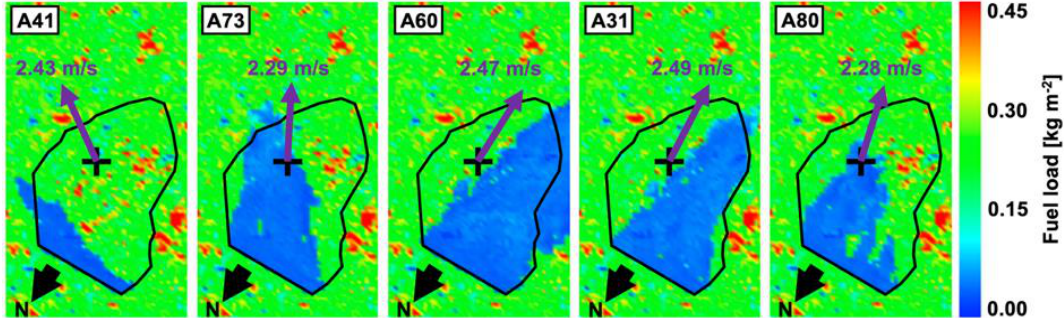
Figure 6. FIRETEC simulations of fuel consumption within the S5 burn plot 320 s after ignition. A black arrow in lower left of each panel denotes direction of magnetic north. All simulations are initialized with wind data from individual anemometers (from left to right) A41, A73, A60, A31, and A60. The purple arrows denote mean direction and associated magnitude of the wind for each simulation. The black outline is the approximate fire perimeter in the Prescribed Fire Combustion and Atmospheric Dynamics Research Experiments (RxCADRE) experiment, based on infrared imagery. In the case of the A60 simulation, the fire burned past the extent of the burn block and continues burning. Fuel consumption is shown on the S5 burn plot domain, not the entire.